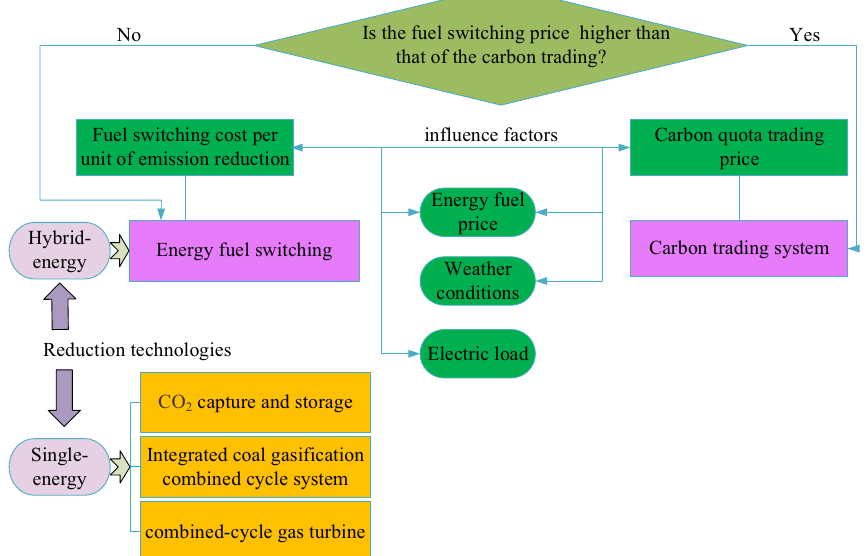
Fig. 1 Carbon-reduction technology for thermal power enterprises and carbon trading